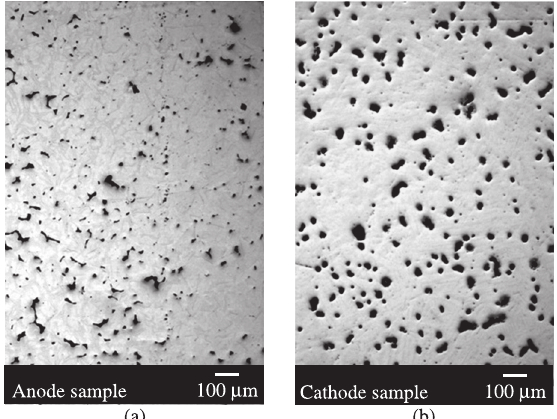
Figure 8. Micrographs of sample compacted under vibration at 600 MPa and sintered in plasma at 1423 K for 3600 seconds.